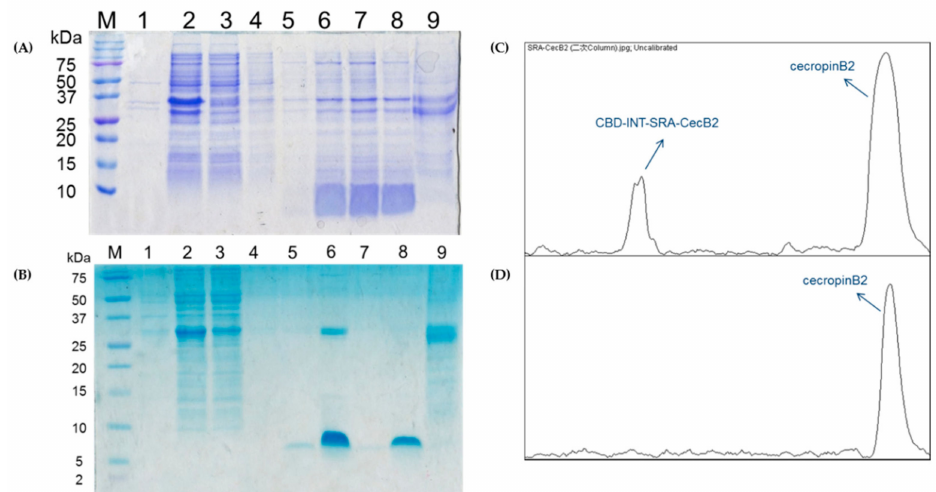
Figure 4. Purification of pTWIN1-CBD-INT- SRA-CecB2 in ( A ) SDS-PAGE—Lane M: marker